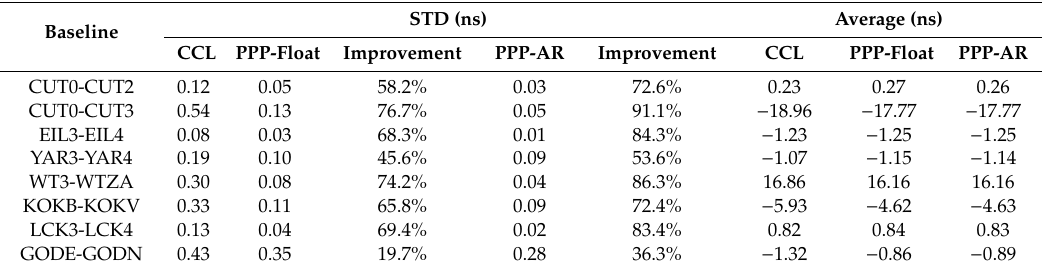
Figure 3. Single di ff erence ionospheric observable retrieved from zero (CUT0-CUT2, ( a )) or short (YAR3-YARR, ( b )) baselines on DOY 100, 2017. The upper panel used the CCL method, the middle panel used the PPP method with float-ambiguity solutions, and the bottom panel used the PPP method with ambiguity resolution. Table 4. The accuracy of the leveling errors for di ff erent